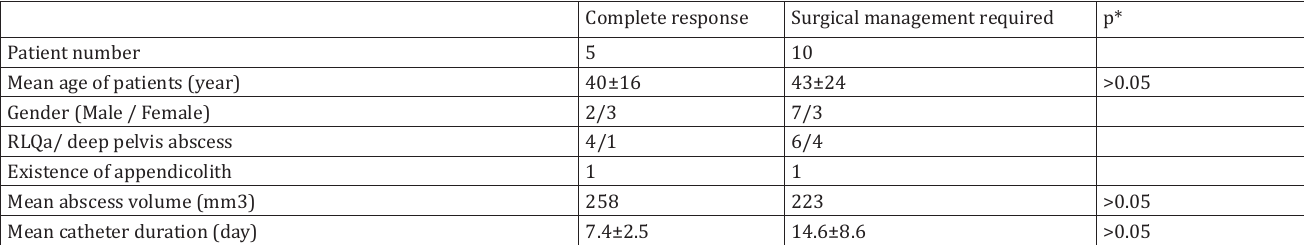
Complete response Surgical management